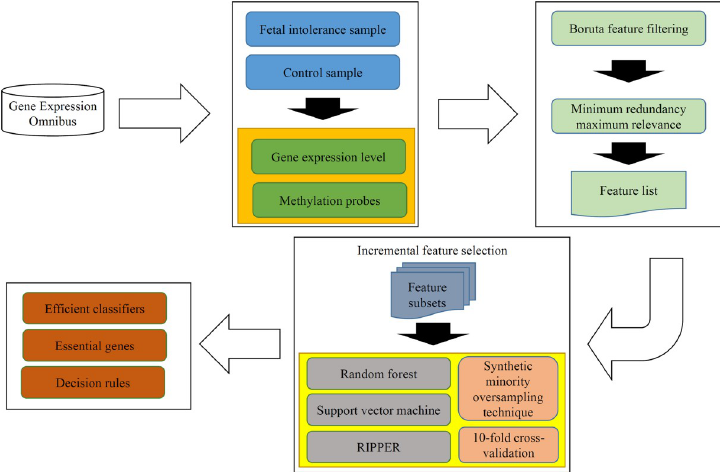
Fig 1. Whole procedures for analyzing the gene expression and methylation profiles of fetal intolerance. The original dataset is retrieved from Gene Expression Omnibus. Some feature selection methods (Boruta feature filtering and minimum redundancy maximum relevance) follow to analyze the dataset, resulting in a feature list. Incremental feature selection generates several feature subsets from the feature list, on each of which a model is built using one of three classification algorithms. Models are tested by 10-fold cross-validation using synthetic minority oversampling technique to tackle imbalanced problem. Finally, some efficient classifiers, essential genes and decision rules are obtained.